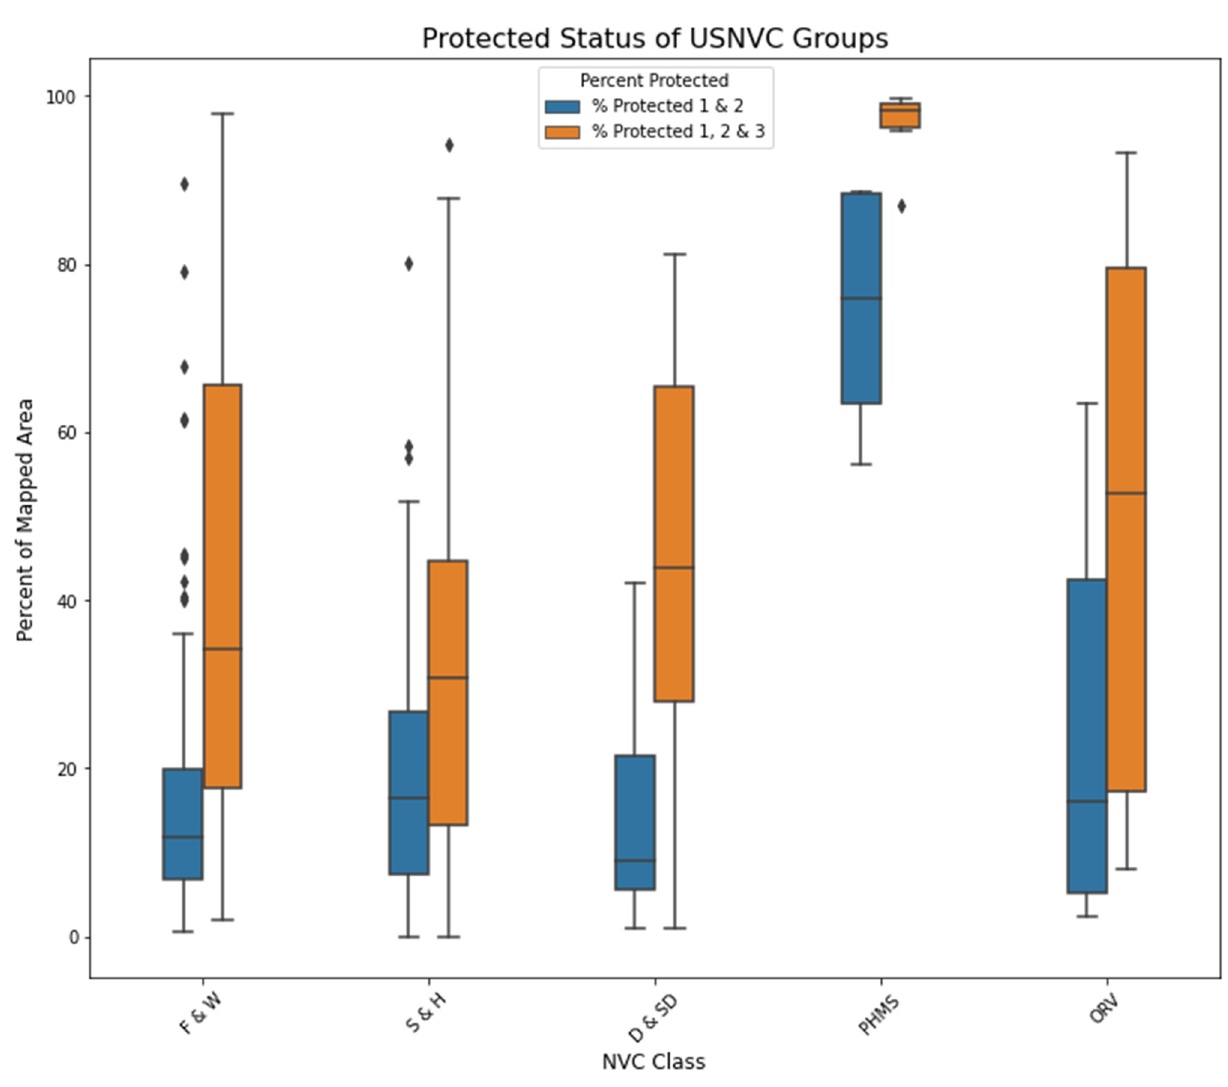
Figure 3. Box plot showing the minimum, maximum and mean representation of United States National Vegetation Classification Groups within each of the five terrestrial vegetation USNVC Classes: F&W Forest and Woodland (120 Groups); S&H Shrub and Herb Vegetation (99 Groups); D&SD Desert and Semi-Desert Vegetation (30 Groups); PHMS Polar and High Montane Scrub, Grassland & Barrens (8 Groups); and ORV Open Rock Vegetation (8 Groups). Groups representing ruderal and plantation vegetation are not included in the analysis.